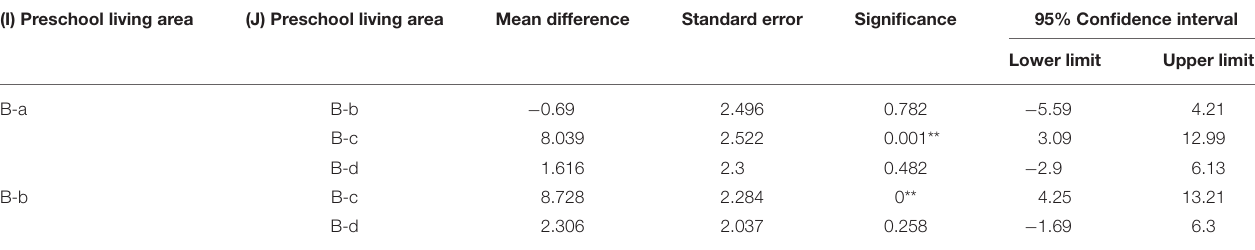
TABLE 4 | Multiple comparisons of the seven varied dominant moods with regard to landscape visual